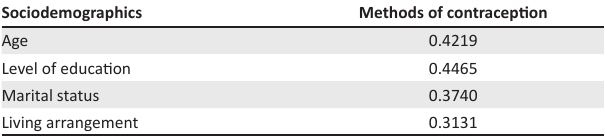
IUCD., Intrauterine Contraceptive Device. FIGURE 2: Contraceptive measures used by the TABLE 4: Comparison between women’s sociodemographics and methods of contraception: Expressed in p -values.